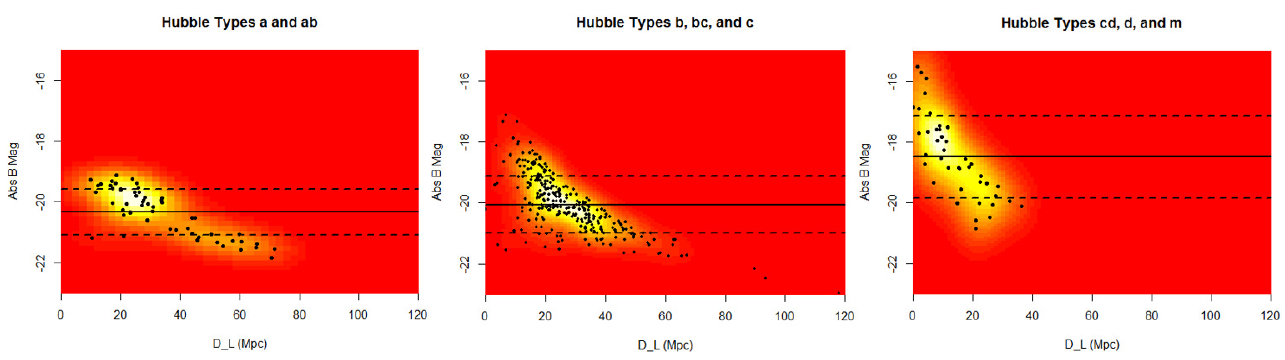
Figure 7. M B vs. D L diagram with mean absolute M B (solid horizontal lines) and standard deviation (dashed horizontal lines) of the full CGS [54] sample, sorted by Hubble type. Hubble types Sa and Sab spirals ( left panel ), as reported in the CGS [54], are confined to roughly M B = − 19mag and brighter, with a mean near M B = − 20.5mag. Galaxies identified as Sb, Sbc, and Sc ( middle panel ) span nearly the whole sample in magnitude. Galaxies identified as Sc, Scd, and Sm ( right panel ) have a mean near M B = − 18.5mag. It is expected that galaxies with later Hubble types have lower surface brightness, especially Sm dwarfs. Galaxy types through Sc, in the CGS [54], all have similar mean M B , while the latest types begin to deviate toward lower brightness. These heat maps illustrate increased clustering of data points with stronger hues of yellow.